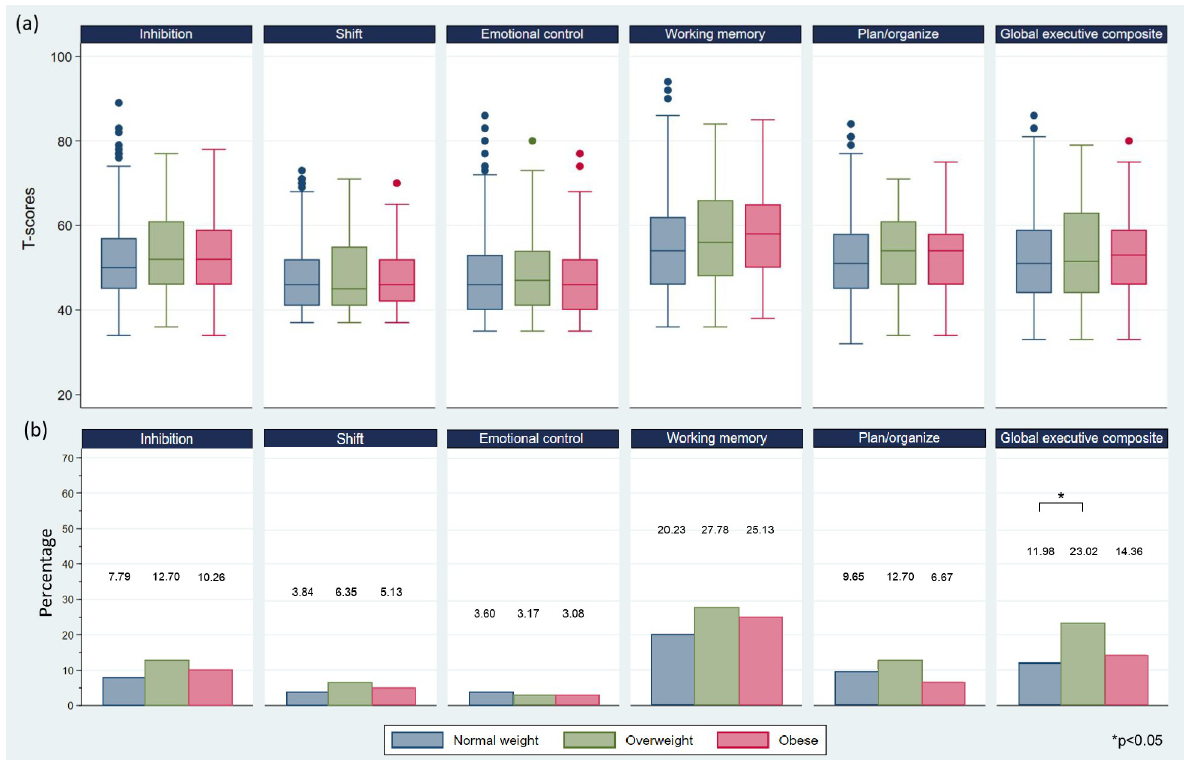
Fig 2. Boxplot and bar chart. The boxplot depicting T-scores of executive function subscales/global executive composite scale (a) and bar chart depicting the percentage of the number of children with impaired executive function among three weight status groups (b).